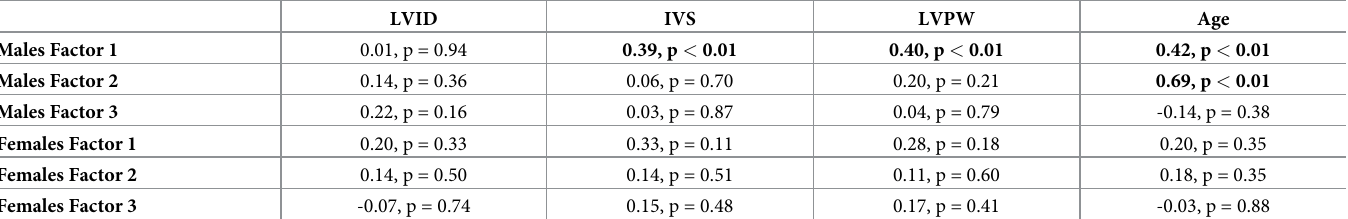
Table 3. Pearson correlations of principal components factor loadings with heart measures and age. The first number is the Pearson correlation coefficient, the second is the significance level (2-tailed).